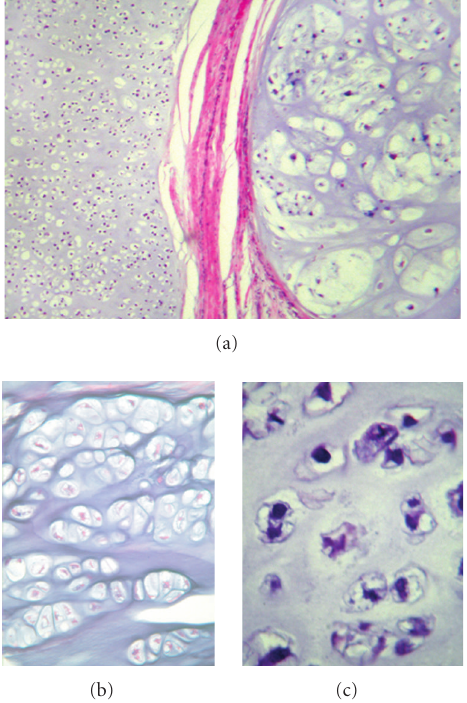
Figure 2: (a) Low-power micrograph (10 × ) of the low-grade chondrosarcoma: H&E stained normal cartilage (left) is separated by a fibrous band from an expansile nodule of malignant cartilage (right). (b) 40 × photomicrograph reveals a region of typical benign cartilage of an osteochondroma, with cells of similar sizes organized in rows. (c) 40 × photomicrograph of malignant cartilage demonstrating both the crowded conditions and the irregular configuration of the large nuclei in the malignant